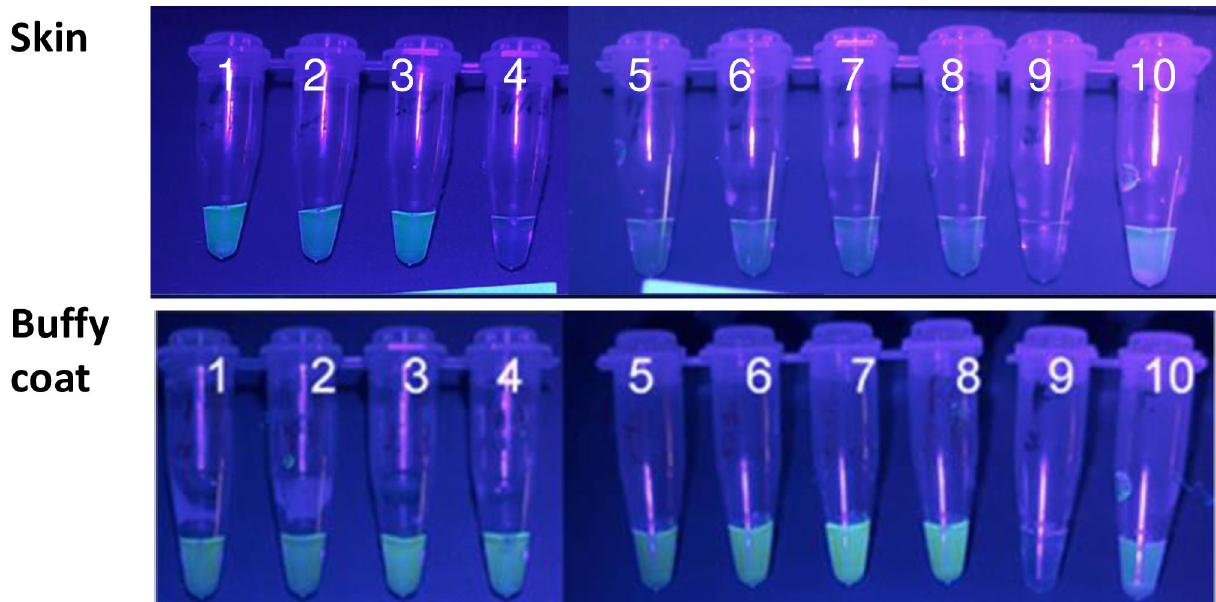
Fig 4. Skin-LAMP and buffy coat LAMP under UV light show higher sensitivity of buffy coat LAMP (samples 1–8); 9, distilled water (no template); 10, positive control.